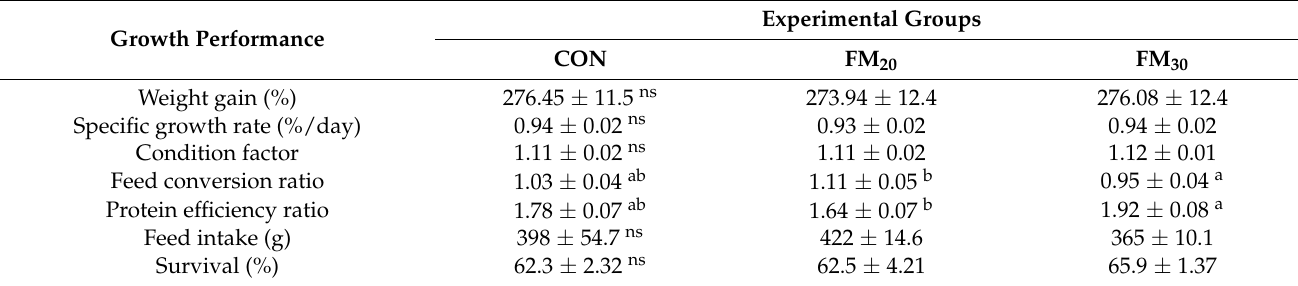
Table 4. Growth performance, feed use, and morphological indices of olive flounders ( Paralichthys olivaceus ) fed experimental diets for 20 weeks.